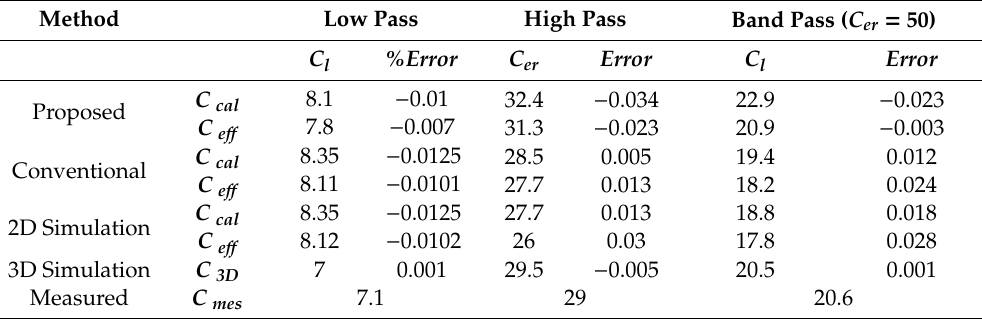
Table 3. Lumped capacitor values in pF for 3 T birdcage